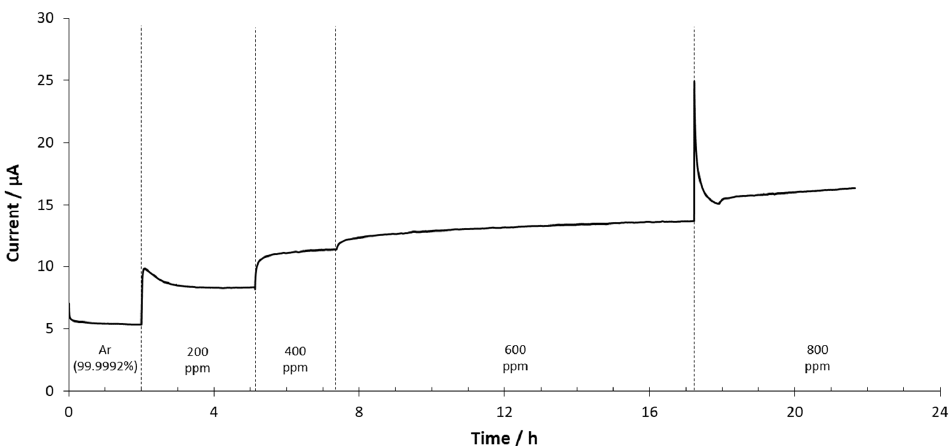
Figure 5. Chronoamperometry performed at 500 °C and 2 V with the SrCeZrYb sensor.